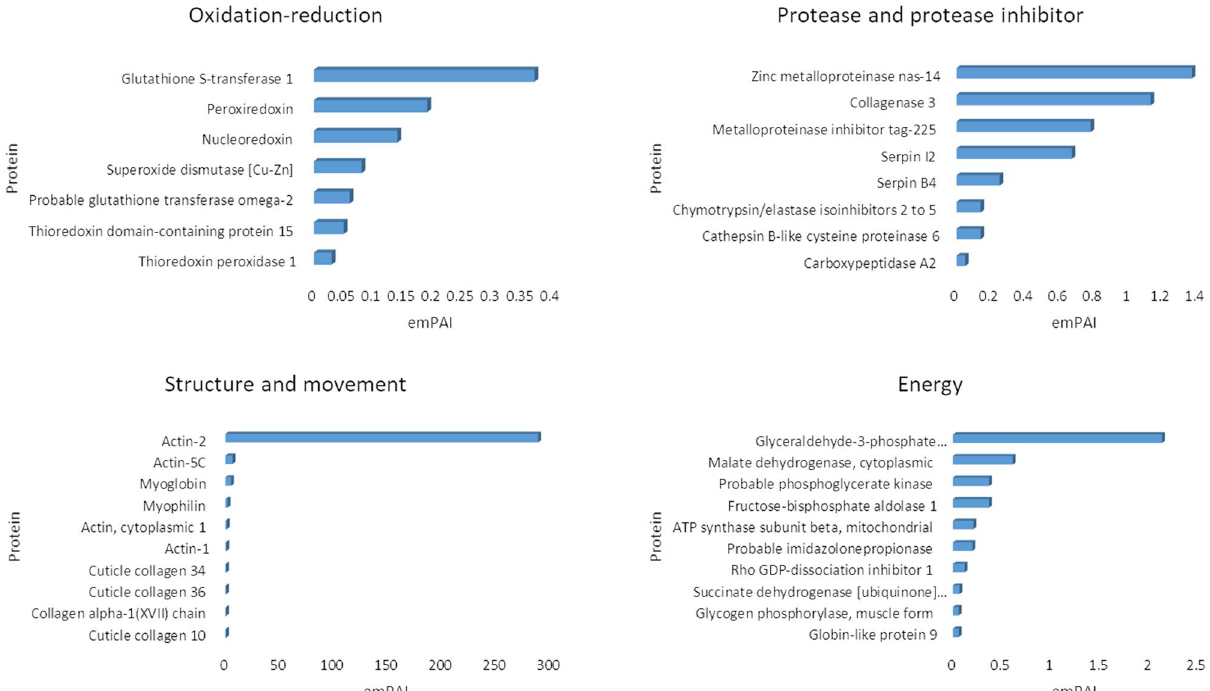
Figure 3. The top-10 most abundant proteins classified by molecular function relating to oxidation–reduction (redox), protease-protease inhibitor activity, structure-movenent, and energy metabolism. Their abundance was estimated semi-quantitatively by emPAI. In each category, the x-axis indicates the emPAI value and the y-axis specifies the protein